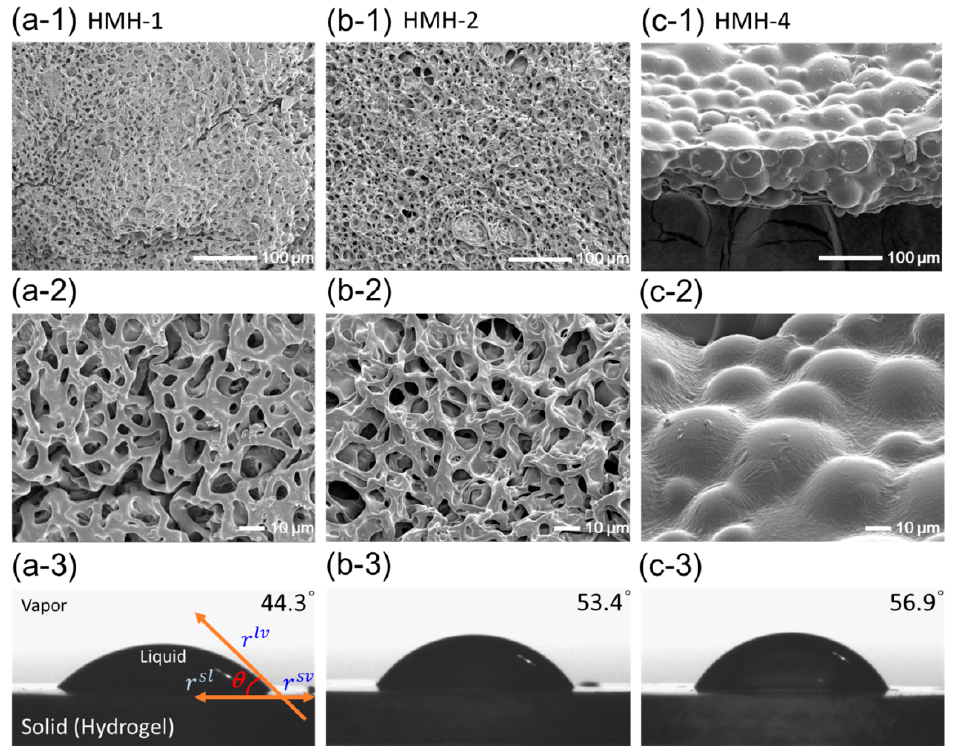
Figure 4. FE-Scanning electron microscope (FE-SEM) images and water contact angles of ( a ) pure PEGDA-575 hydrogel (HMH-1), hydrophobically-modified hydrogel, HMH-2 ( b ) at 0.5 wt % of PPGMAs and HMH-4 ( c ) at 2.0 wt % of PPGMAs.